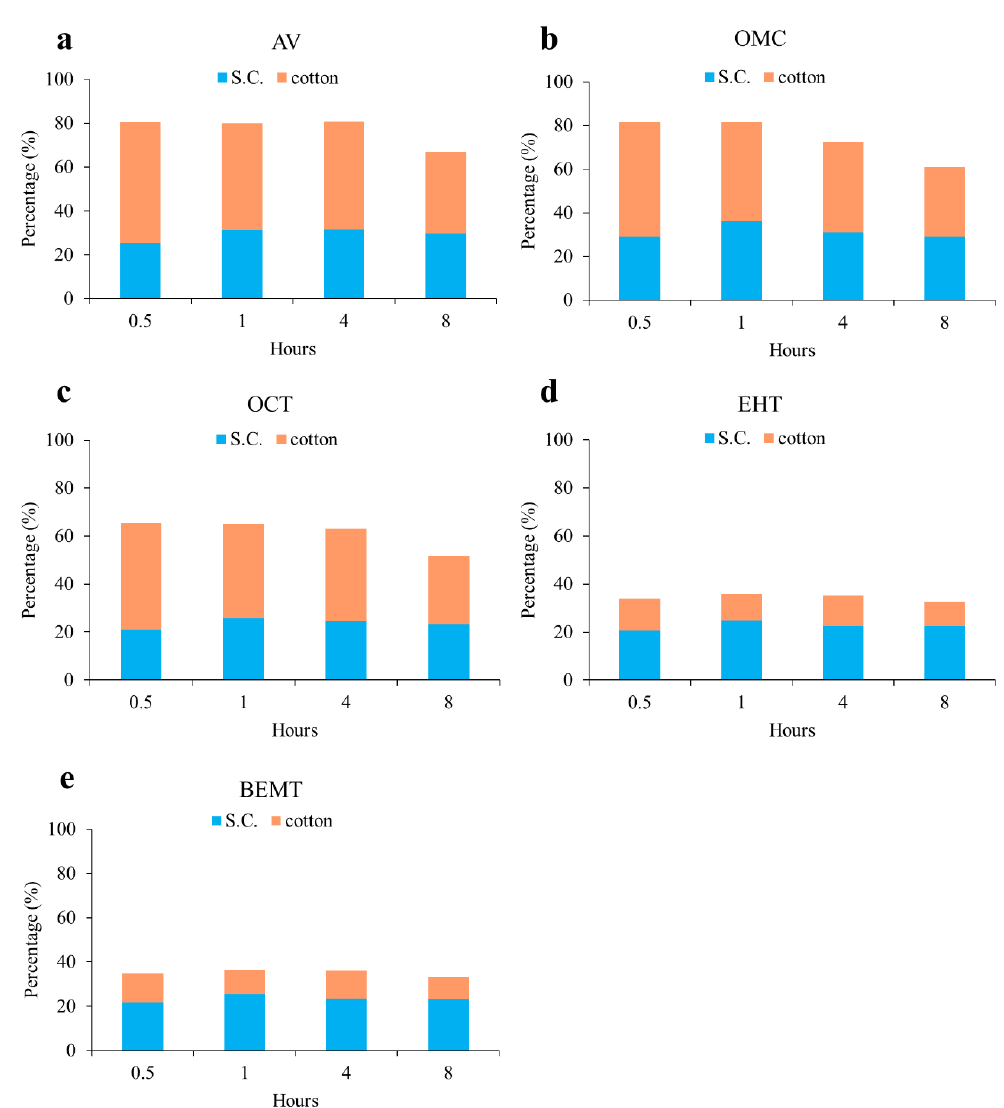
Figure 5. Percentages of UV filters in the cotton (non-penetrated) and the stratum corneum extract after the application of the home-made sunscreen (w/o) on human skin for 0.5, 1, 4, and 8 h of exposure. Table 5. UV filter contents of cup-method samples after single or double applications of the home- made sunscreen (w/o) for 8 h (subjects = 10).